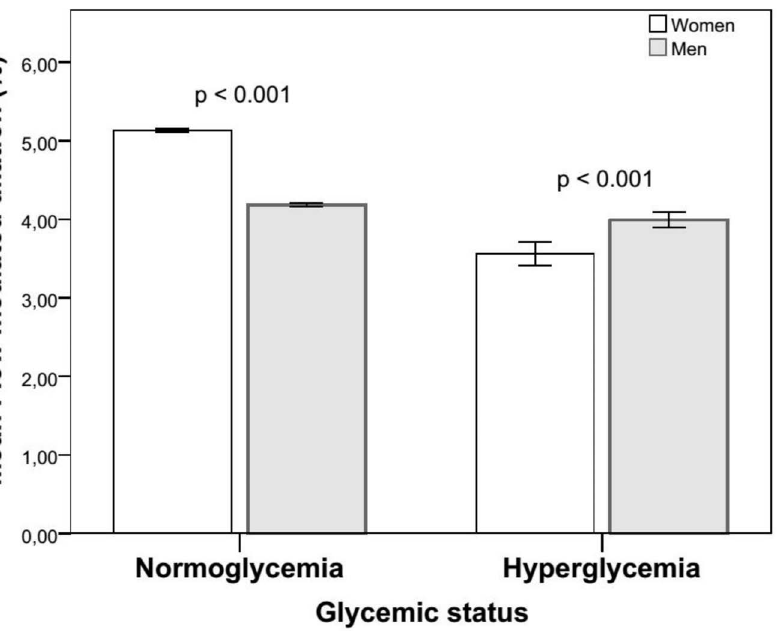
Figure 2. Gender difference in flow-meditated dilation with glycemic status. Mean flow-mediated dilation adjusted for age and its dependence on glycemic status are shown separately for women and men. Vertical lines indicate 95% confidence intervals. Difference between normo-and hyperglycemic women, p=0.003, men p=0.91.